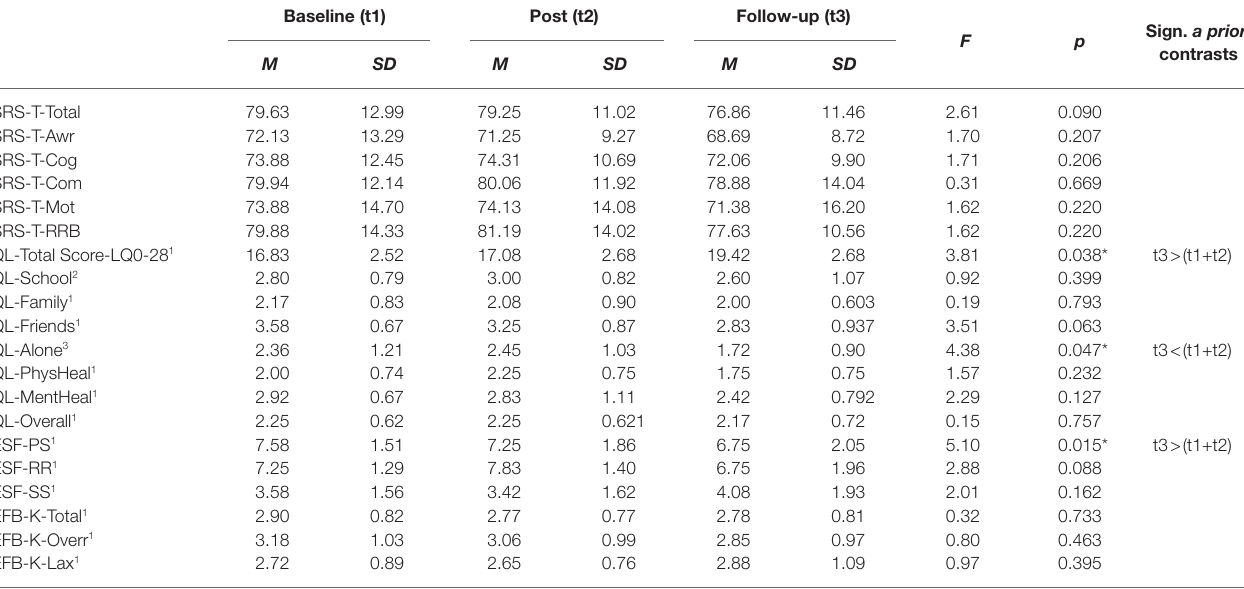
TABLE 3 | Baseline (t1), post (t2), and follow-up (t3) statistics of the primary and secondary outcome measures ( N = 16). Baseline (t1) Post (t2)